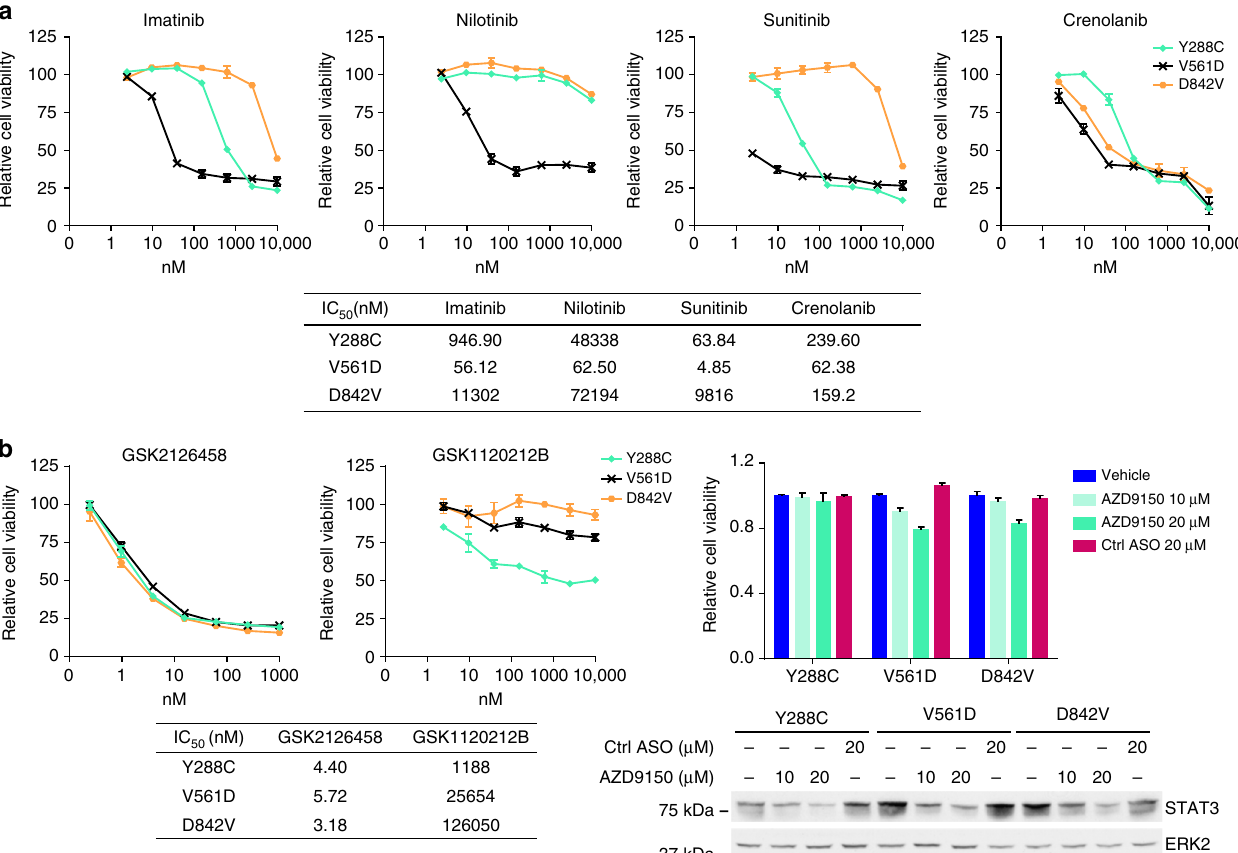
Fig. 6 PDGFR inhibitors have limited ef fi cacy against Y288C mutation. MCF10A cells expressing PDGFRA mutants were treated with DMSO or 2.44nM-10